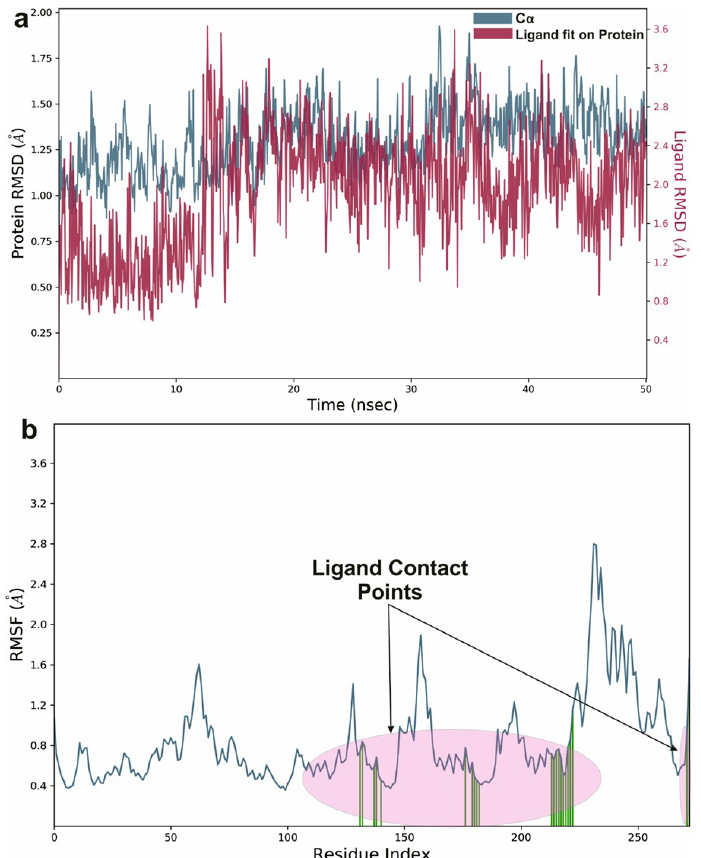
Figure 12. Graphical representation of ( a ) root-mean-square fluctuation for Orientin with active site residues of NQO1 after MDS and ( b ) ligand RMSD plot to show the contact point pf the ligand with the amino residue of the NQO1 represented as green color vertical green lines with several contact